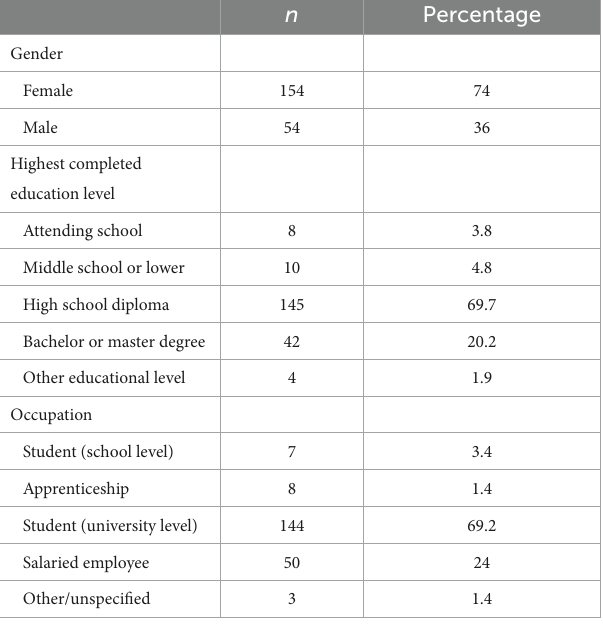
TABLE 1 Sociodemographic characteristics of